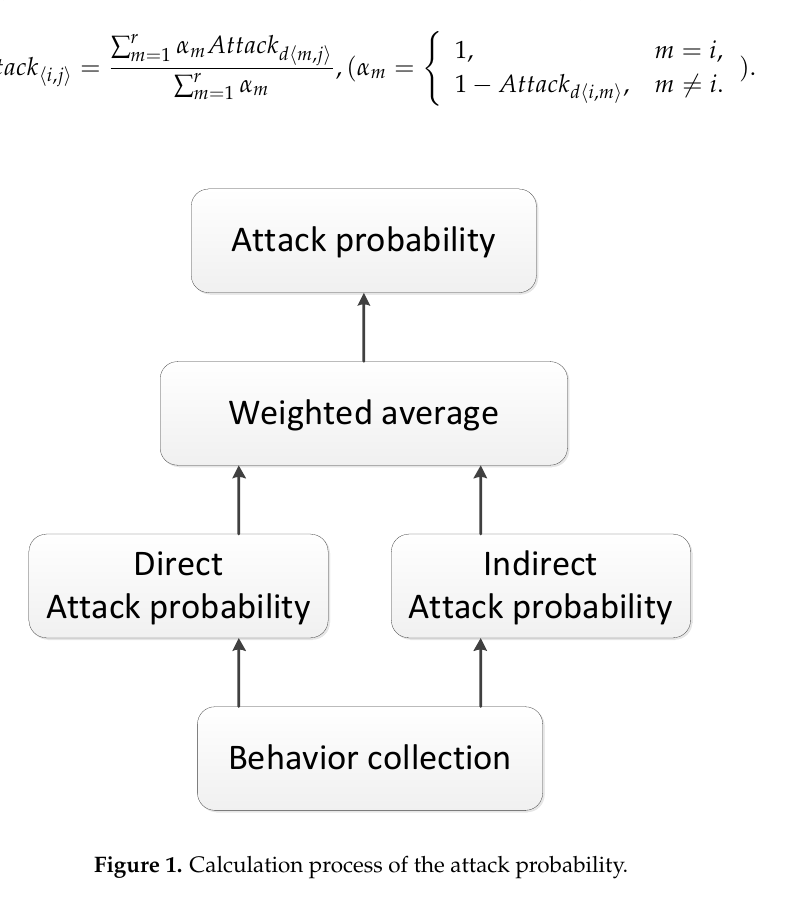
Figure 1. Calculation process of the attack probability.